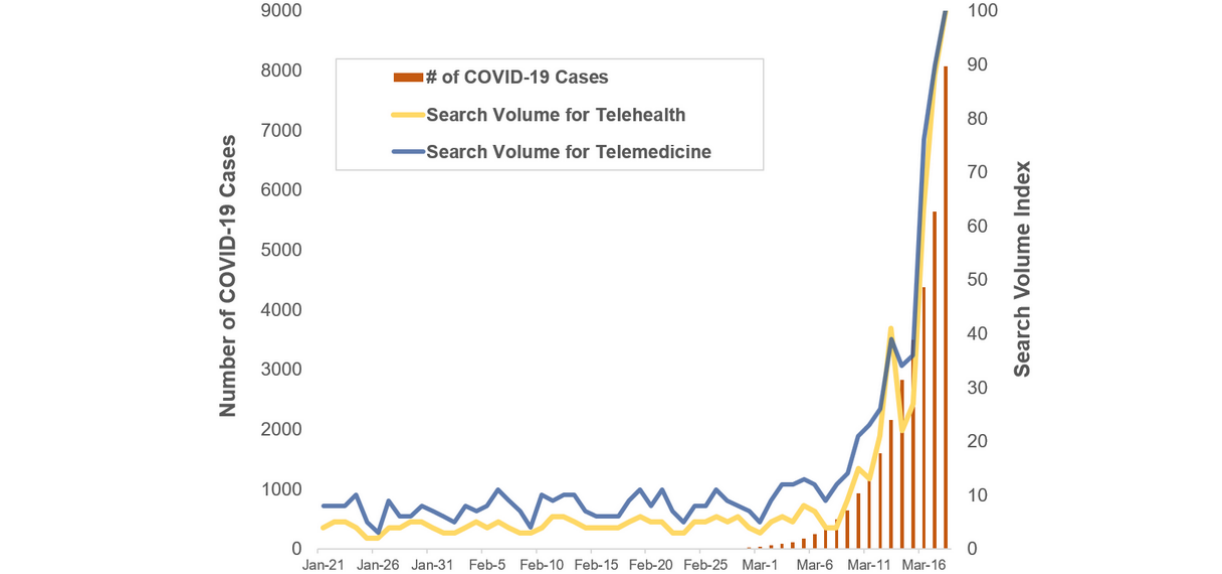
Figure 1. Trends in search volume for telehealth and the number of COVID-19 cases in the United States.